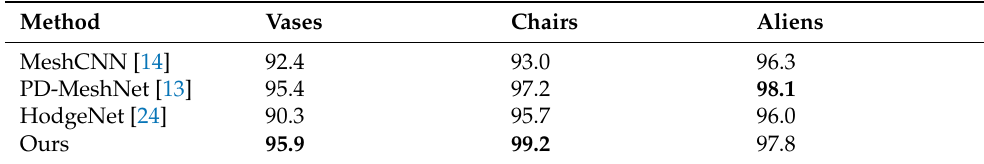
Table 2. Segmentation results on COSEG with faces labels.